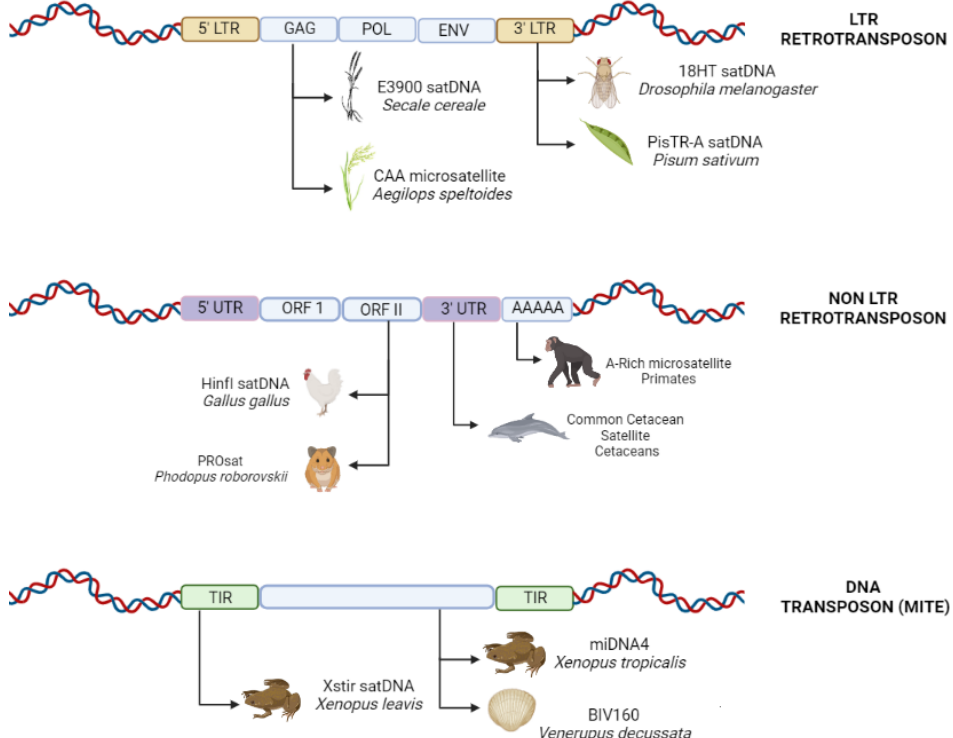
Figure 2. Schematic diagram of the different regions of transposable elements that may provide the starting point of origin for new micro-, mini- or satellite DNA. LTR (Long Terminal Repeat); GAG (GAG domain); POL (Reverse Transcriptase); ENV (Envelope Protein); UTR (Untranslated Region); ORF (Open Reading Frame); TIR (Terminal Inverted Repeats). (Source: the authors/created in Biorender.com, accessed on 5 September